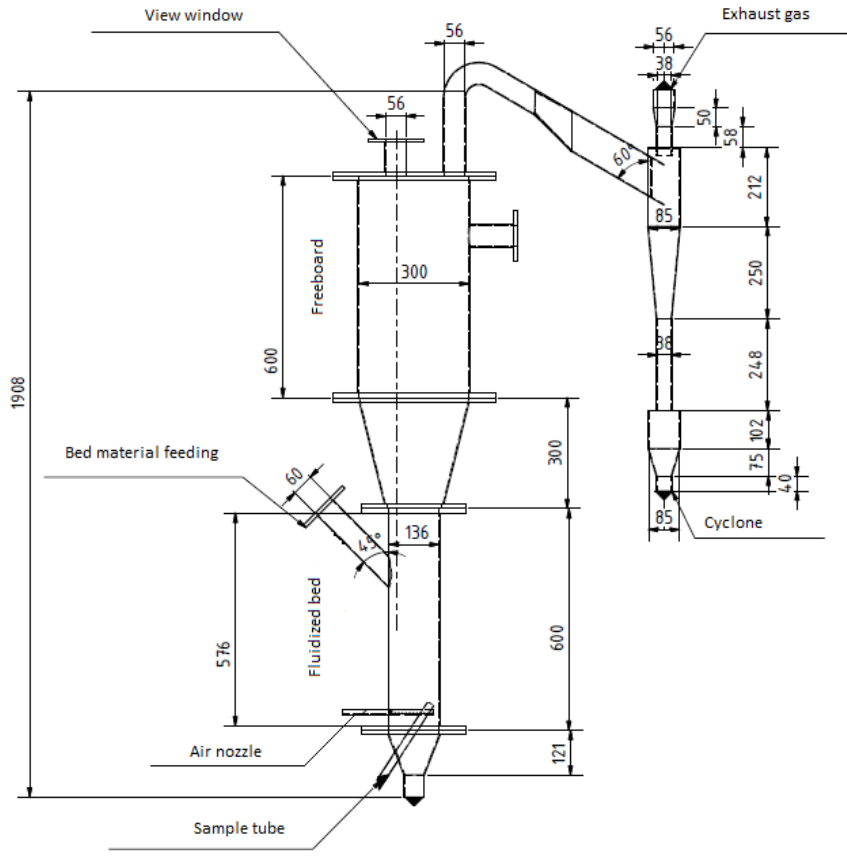
Figure 2. Scheme of the bench-scale bubbling fluidized bed reactor. All dimensions are in mm.